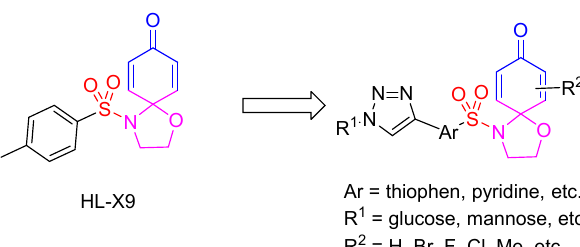
Figure 2. Design of novel sulfonylazaspirodienone derivatives from 4-tosyl-1-oxa-4-azaspire[4.5] deca-6,9-dien-8-one